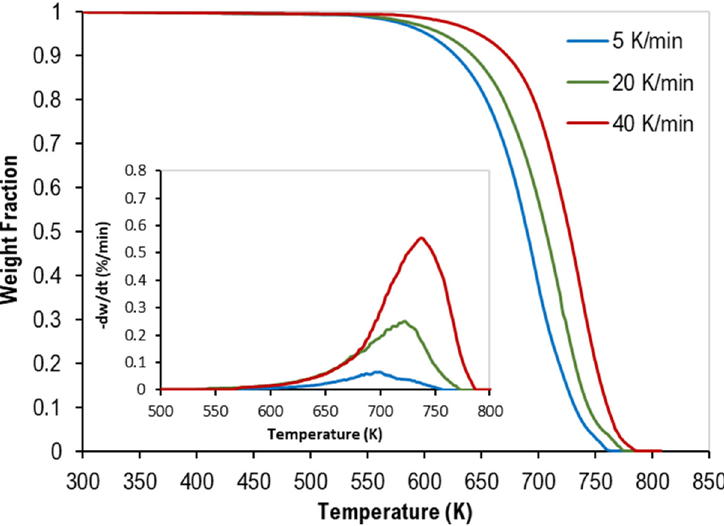
Figure 2. TG curves of ternary mixtures of PP, PS, and LDPE with DTG curves inside.